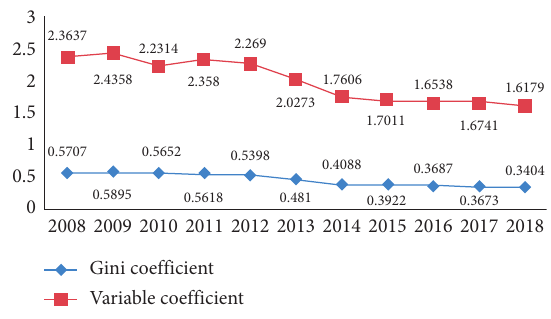
Figure 2: Differences and dynamic changes in innovation output of YREZ from 2008 to